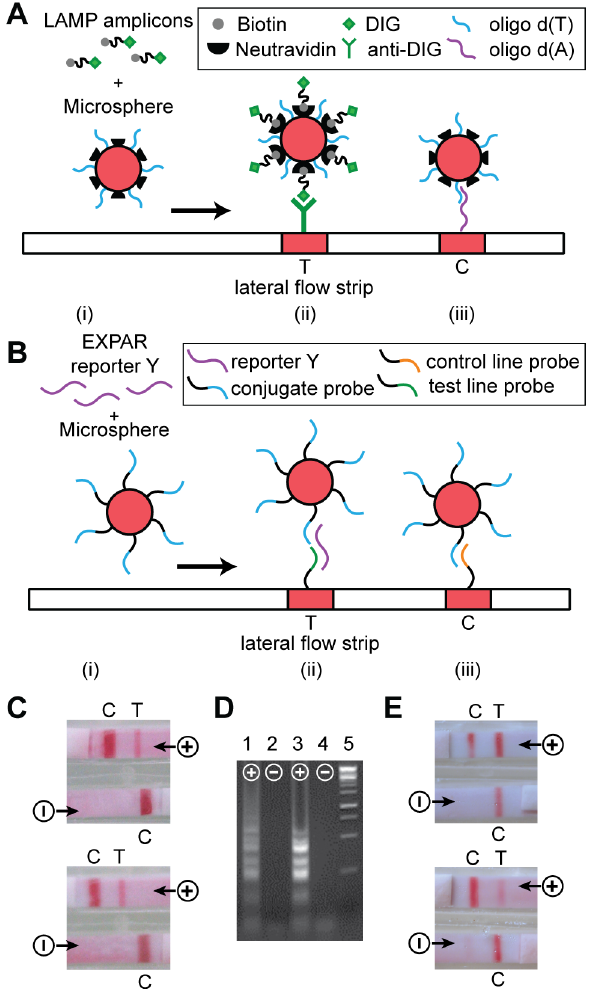
Figure 4. Isothermal DNA amplification coupled to NALF detection. Conceptual depiction for (a) LAMP, and (b) EXPAR. (i) amplified master-mix applied to the conjugate pad enables amplicons to interact with colored polystyrene microspheres functionalized with appropriate capture moieties. (ii) After migrating along the nitrocellu- lose membrane, microspheres carrying amplicons are captured at the test line. (iii) At the control line, microspheres are captured irrespective of the presence of amplicon. (c) LAMP based detection of M.tb genomic DNA performed in the cartridge on the instrument: NALF strips of two representative cartridges, after 10 minutes of isothermal amplification, followed by 10 min for lateral flow detection. (d) LAMP master-mix amplified in the cartridge on the heater, analyzed via gel electropho- resis (Lanes 1 and 2), compared to amplification performed in reaction tubes on a standard heat block (Lanes 3 and 4). Lane 5: DNA molecular weight markers. For (c) and (d), positive ( + ) reactions show LAMP product starting from 3000 copies of M.tb DNA, and negative ( 2 ) reactions show no product since no M.tb DNA was added to the reaction. (e) EXPAR based detection of M.tb genomic DNA performed in the cartridge on the instrument: NALF strips of two representative cartridges, after 60 minutes of isothermal amplification, followed by 10 min for lateral flow detection. Positive ( + ) reactions contained 6 6 10 5 copies M.tb DNA, and negative ( 2 ) reactions contained no M.tb